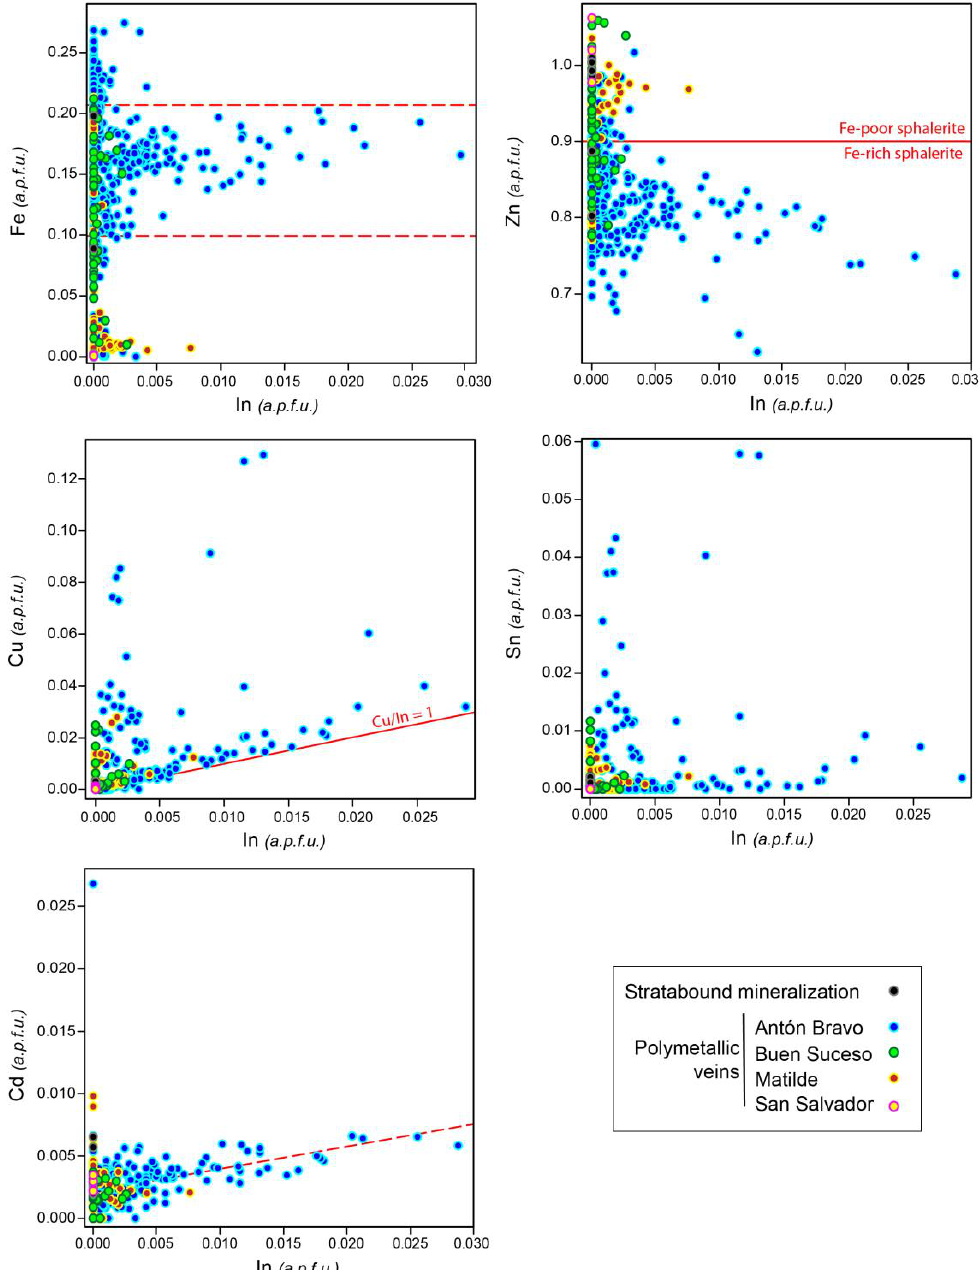
Figure 10. Correlation between In and other elements in sphalerite from the Huari Huari district.